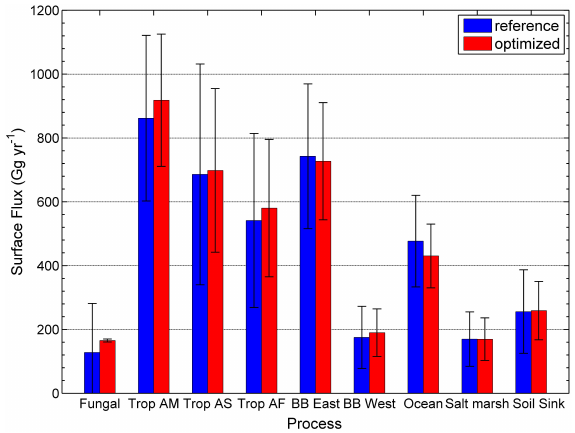
Fig. 11. Annual average CH 3 Cl surface flux magnitudes. Shown are the reference (blue bars) and optimized (red bars) values with their 1 σ error bars (black). The errors on the references are the assumed a priori inversion uncertainties of ± 30% to ±